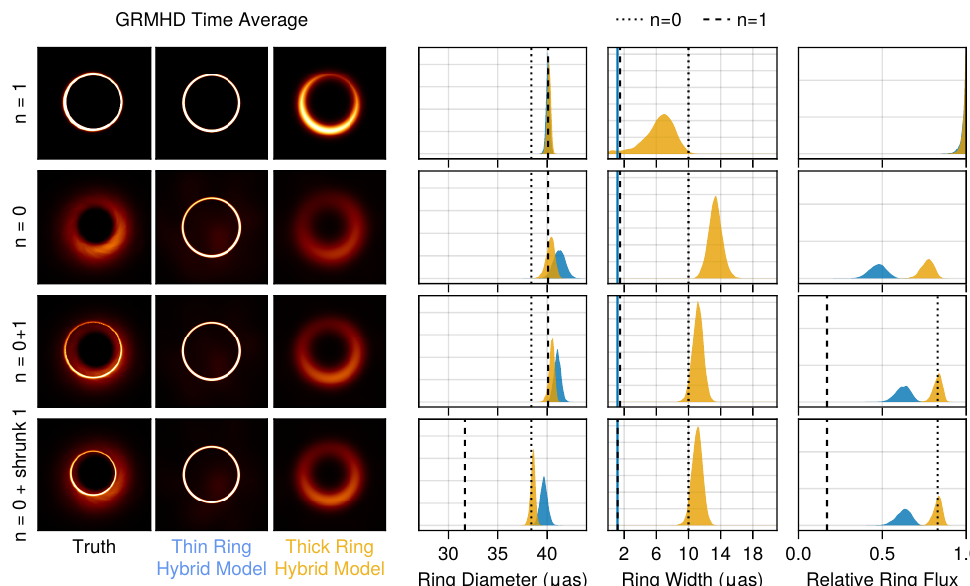
Figure 5. Results of fitting a time-averaged GRMHD simulation with coverage corresponding to the EHT 2017 array, following the same procedure and format of Figure 4. The GRMHD simulation has a spin of 0.5, inclination of 163 ◦ , r high = 20, and is in the MAD accretion state.